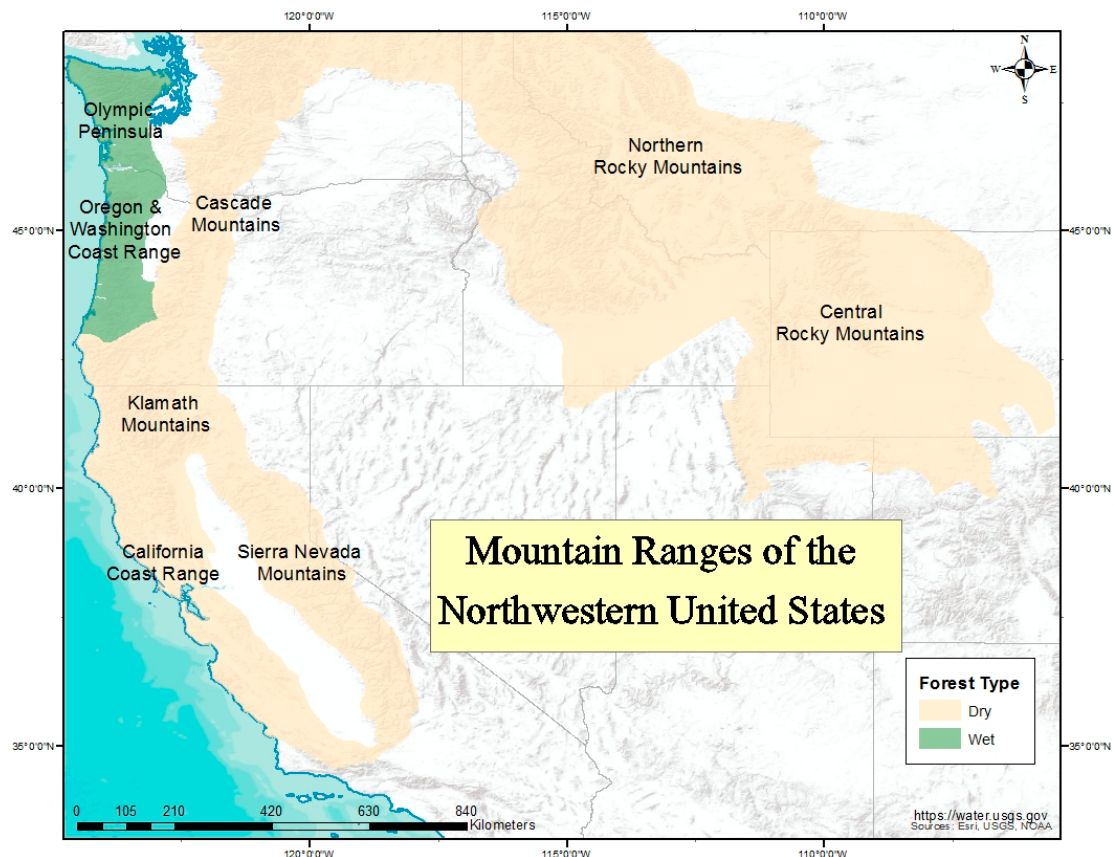
Figure 1. Map of mountain ranges of the northwestern United States and California showing the distribution of wet and dry forest types.